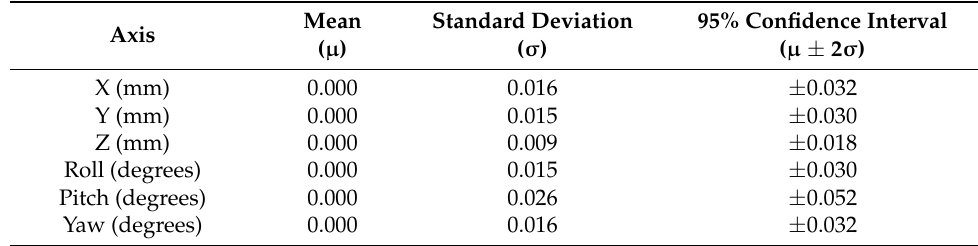
Table 4. Statistical characteristics of a 95% confidence interval for the bottom interface of an intersti- tial